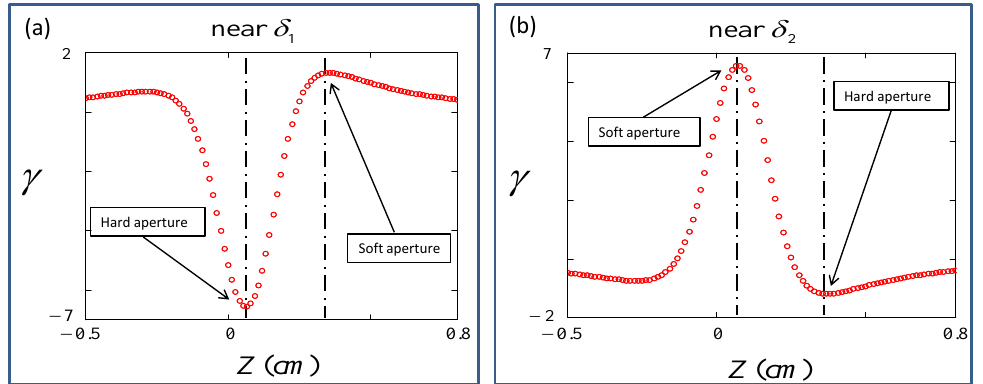
Figure 5. ( a ) Kerr strength γ at EM 1 as a function of the crystal position, Z , near the stability limit, δ . At Z = 0 , the crystal center is located at a distance f 1 values of Z correspond to the translation of the crystal away from mirror M 1 . ( b ) Kerr strength γ as a function of the crystal position, Z , at EM 2 near the stability limit, δ At Z = 0 , the crystal center is located at a distance, f correspond to the translation of the crystal away from M 2